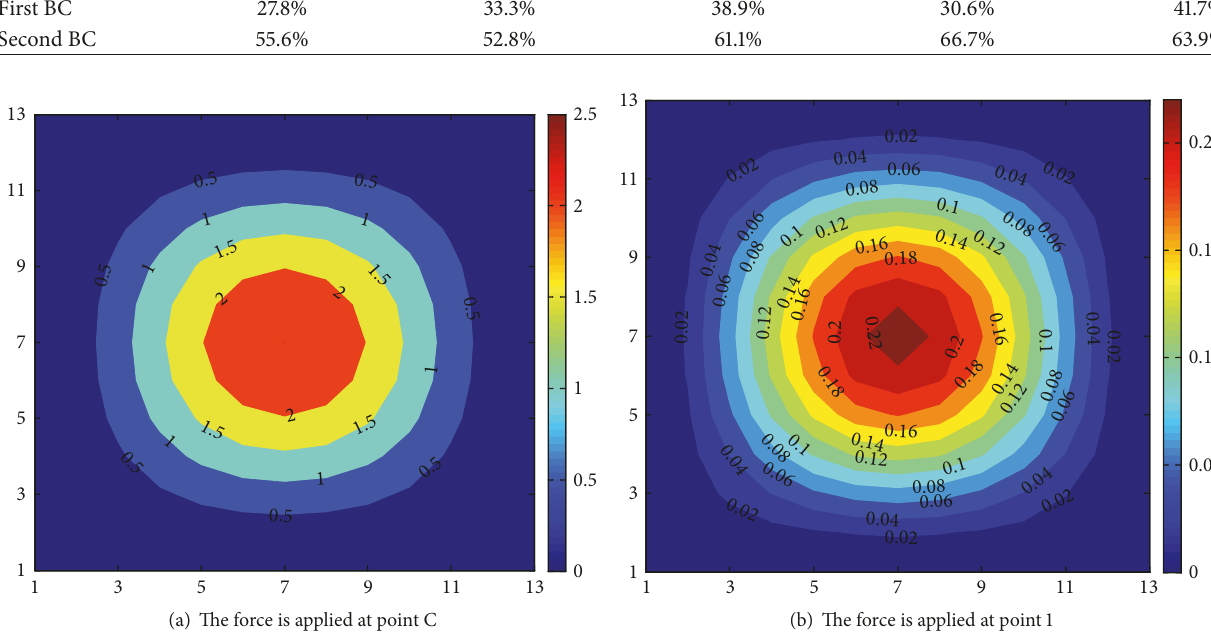
Figure 21: The vibration normal velocity in the full coverage plate with CLD materials for second